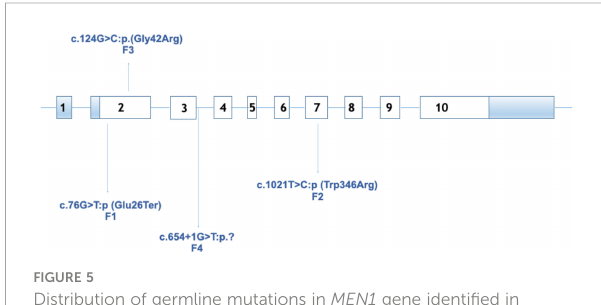
FIGURE 5 Distribution of germline mutations in MEN1 gene identi fi ed in individuals from each family of our study (NM_130799.3). F1, family 1; F2, family 2; F3, family 3; F4, family